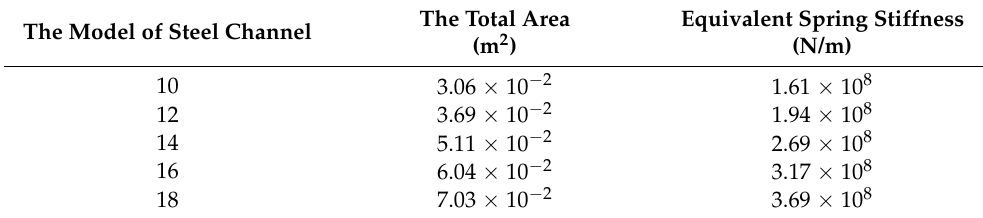
Table 5. Equivalent spring stiffness of steel channels under different models.